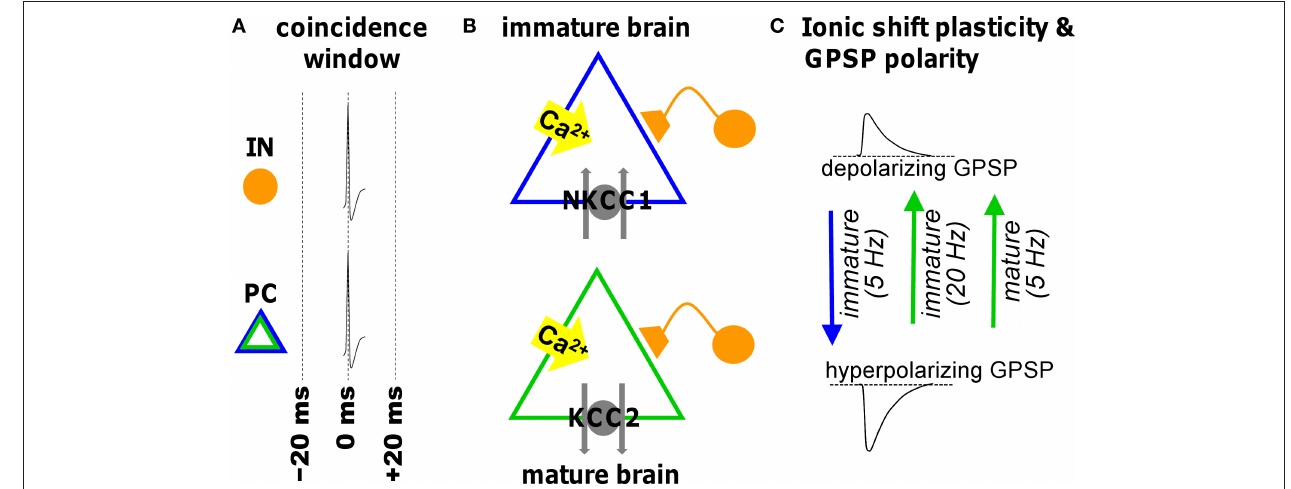
FiGure 2 | illustration of ionic shift plasticity in synaptically connected interneuron (iN) -principal cell (PC) pair in immature and mature brain. (A) Repetitive concurrent firing of the two cells inside the coincidence window activates a cascade that shifts the reversal potential of GABAergic PSPs (GPSP). (B) Spiking-associated calcium influx regulates cation-chloride